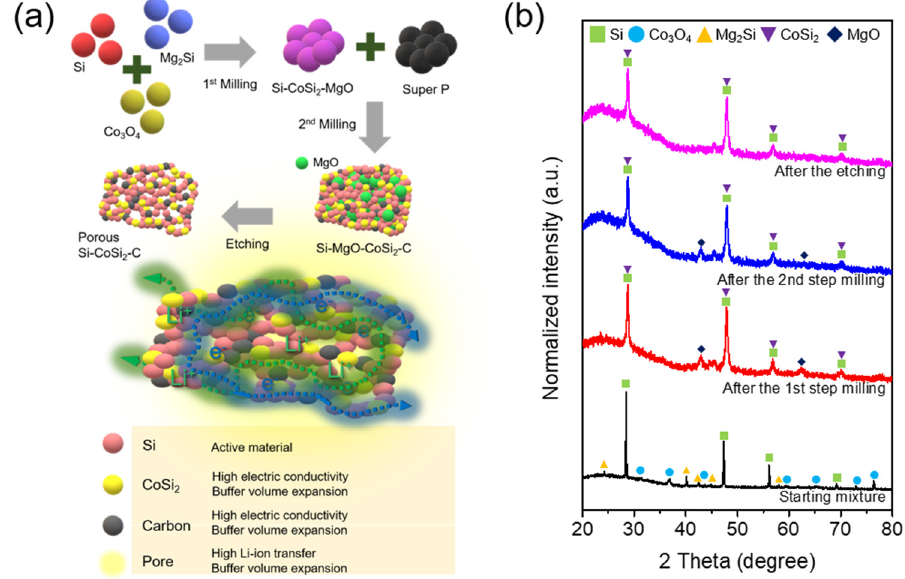
Figure 1. ( a ) Schematic of the porous Si-CoSi 2 -C composite with the roles of each component and ( b ) XRD patterns of the pristine mixture and the samples after each synthesis.